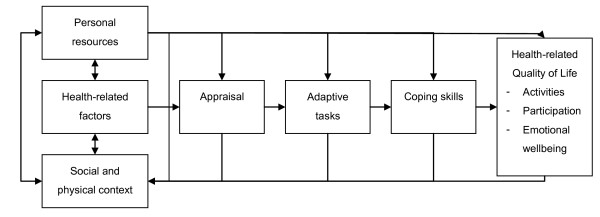
Stress-coping model.